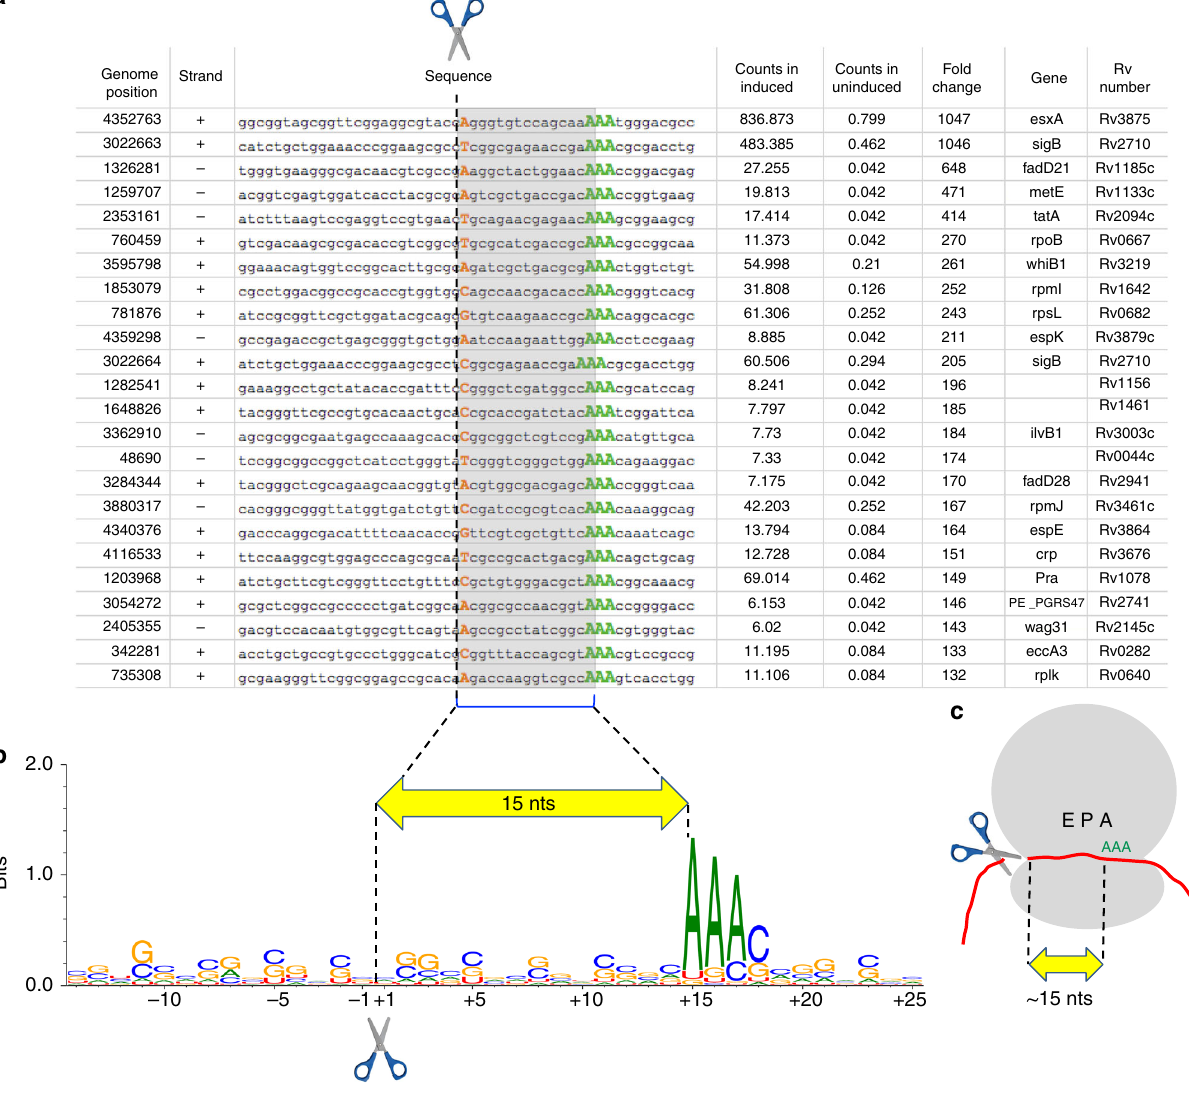
(Fig. 3). MazF-mt9 cleaves tRNA Lys23-UUU and exhibits the same